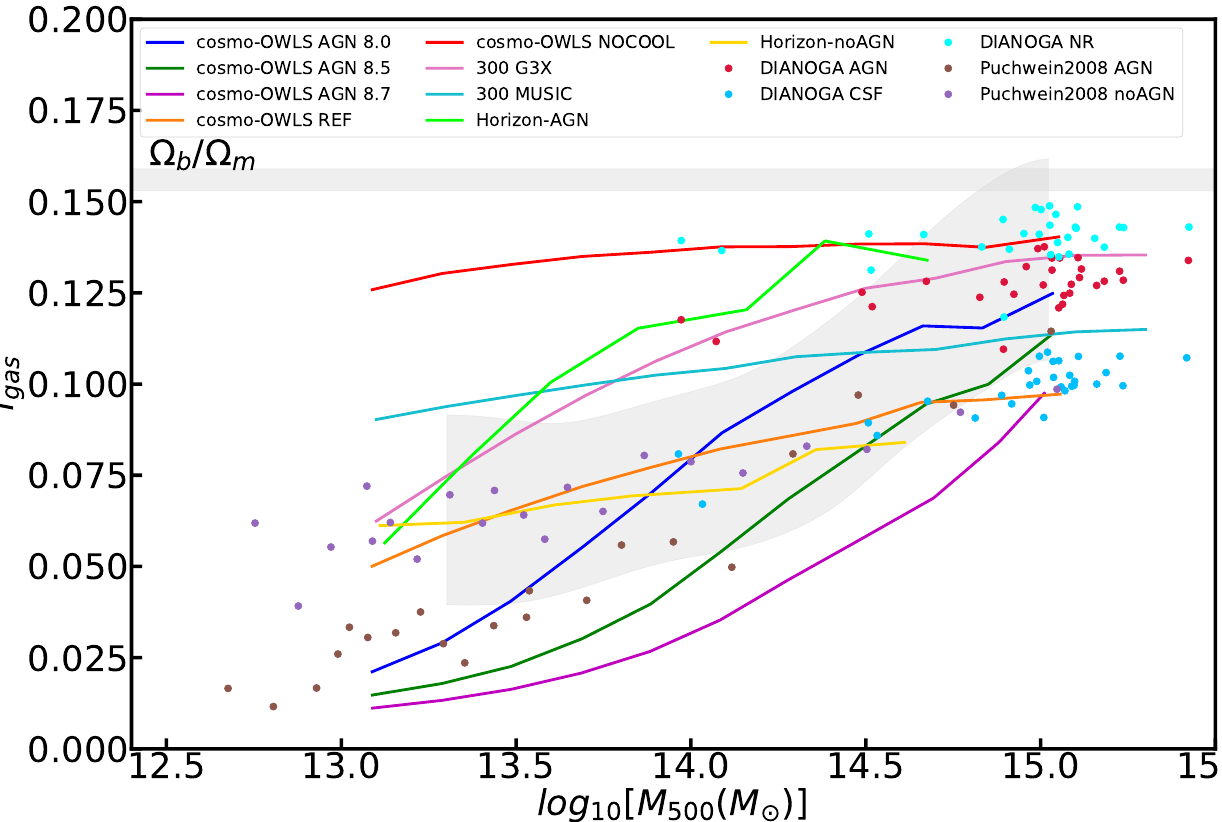
Figure 14. Compilation of historical simulation results for the gas fraction within R 500 as a function of M 500 . The red, orange, magenta, green and dark blue solid lines correspond to the different sub-grid models of cosmo-OWLS [12], the pink and cyan ones to the 300 clusters run with the GADGET3X [311] and MUSIC [312] codes, respectively, as part of The Three Hundred Project [313], the lime and gold ones correspond to Horizon-AGN and, its counterpart without AGN, Horizon-noAGN [283], the cyan, blue, and crimson ones to the various physical models of the DIANOGA suite [314] and, finally, the purple and brown symbols correspond to the simulations of [22] without and with AGN, respectively. The compilation of observations presented in Figure 7 is shown as a gray